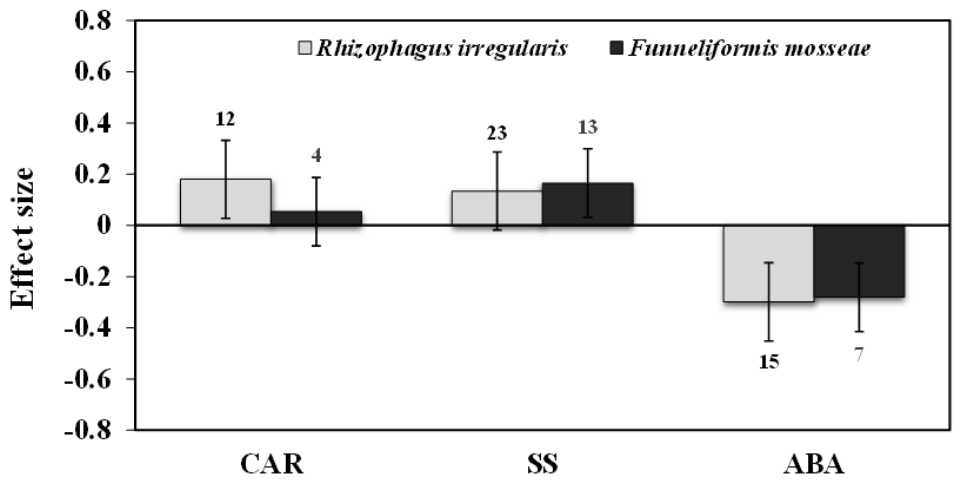
Figure 8. Categorical analysis of AMF species on CAR, SS, and ABA levels. Error bars are means ±95% confidence intervals (CIs). Where the CIs do not overlap the horizontal lines, the effect size for a response variable is significant at p < 0.05. The numbers of observations are shown above the bar. Note: CAR − Carotenoids, SS − Soluble sugars, ABA − Abscisic acid.